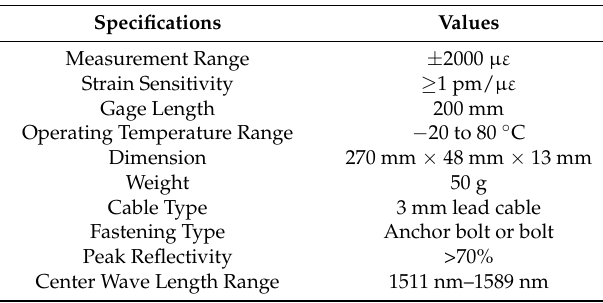
Table 1. Specifications of the FBG strain sensor.